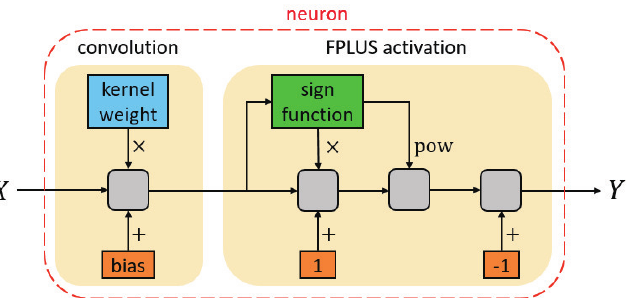
Figure 5. A neuron in the convolutional layer with FPLUS unit embedded as the activation gate. X indicates the input, which may be normalized before, and Y denotes convolutional output after indispensable excitation.